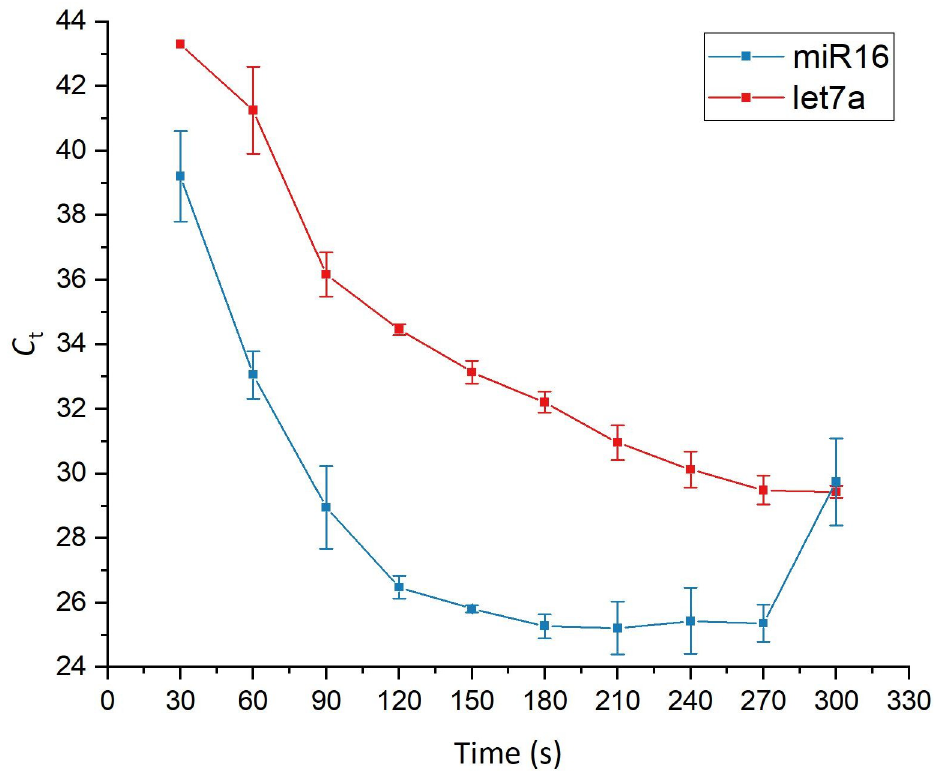
Fig 6. Time series for the extraction of miRNAs from 5000 MCF7 cells. Black: miR16; Red: let7a (n = 3).